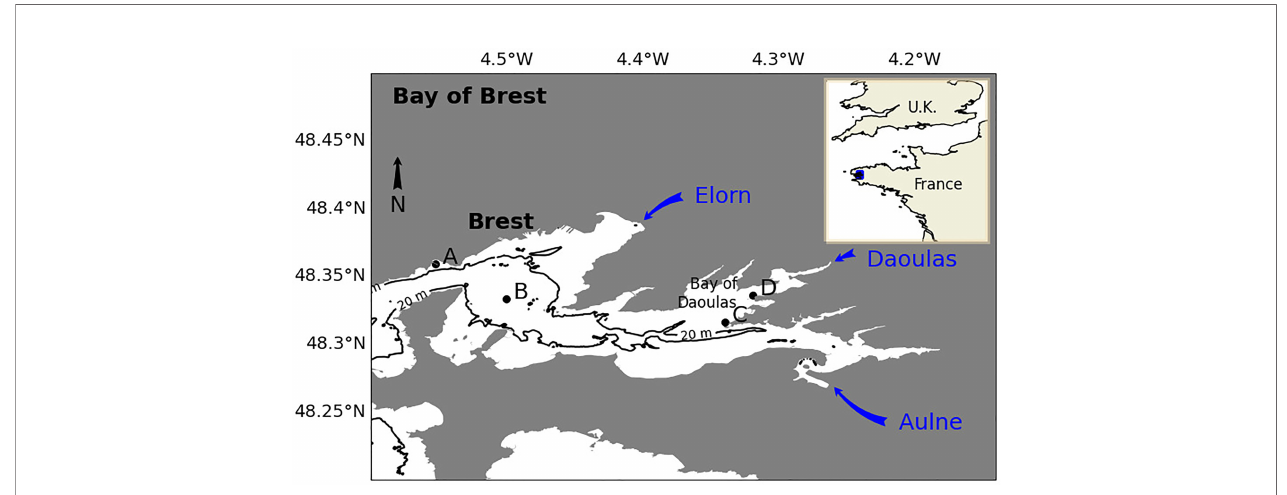
FIGURE 2 | Positions of the monitoring stations in the Bay of Brest: (Station A): Ste Anne du Portzic station from SOMLIT program (Observatory in the coastal environment, http://www.somlit.fr); (Station B): Lanveoc from REPHY national program; (Station C): PRIMROSE IFC mooring at Anse du Roz in the Daoulas estuary; (Station D): Alex Breizh mooring and sampling site at Pointe du Cha ̂ teau in the Daoulas